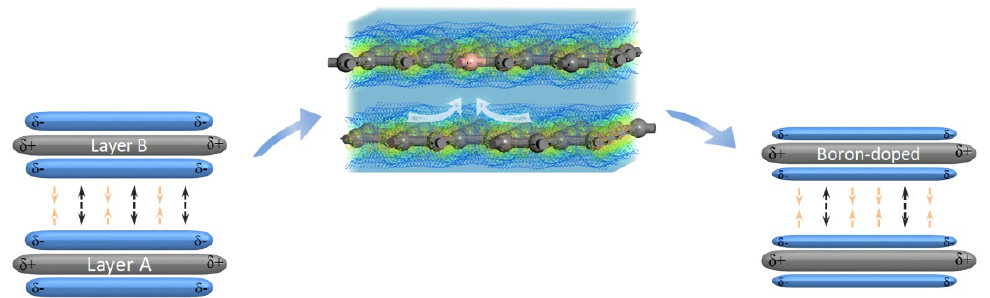
Figure 8. The mechanism of the effect of sub-B on the electronic structure and interlayer spacing of graphite.